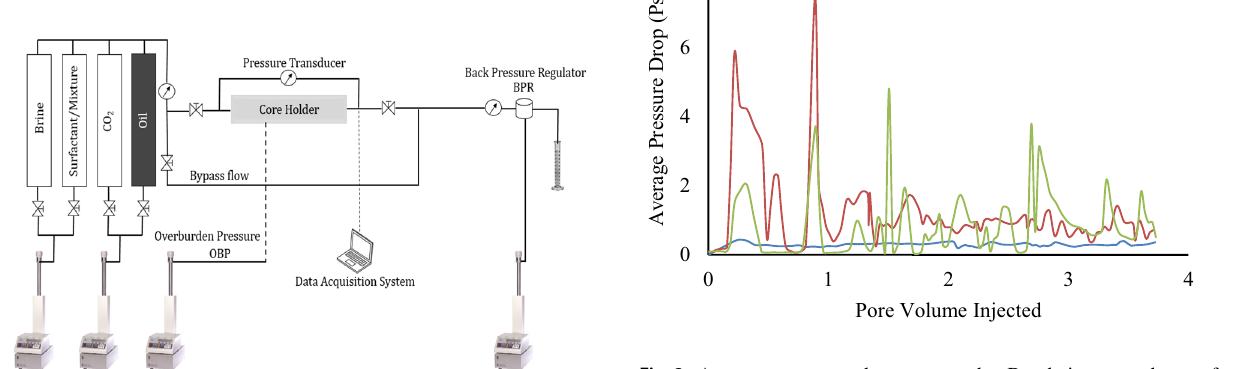
Fig. 2 Average pressure drop across the Bentheimer sandstone for baseline, 0.50 wt % surfactant, and a mixture of 0.50 wt % surfactant and 0.50 wt % NPs at 50 °C using CO